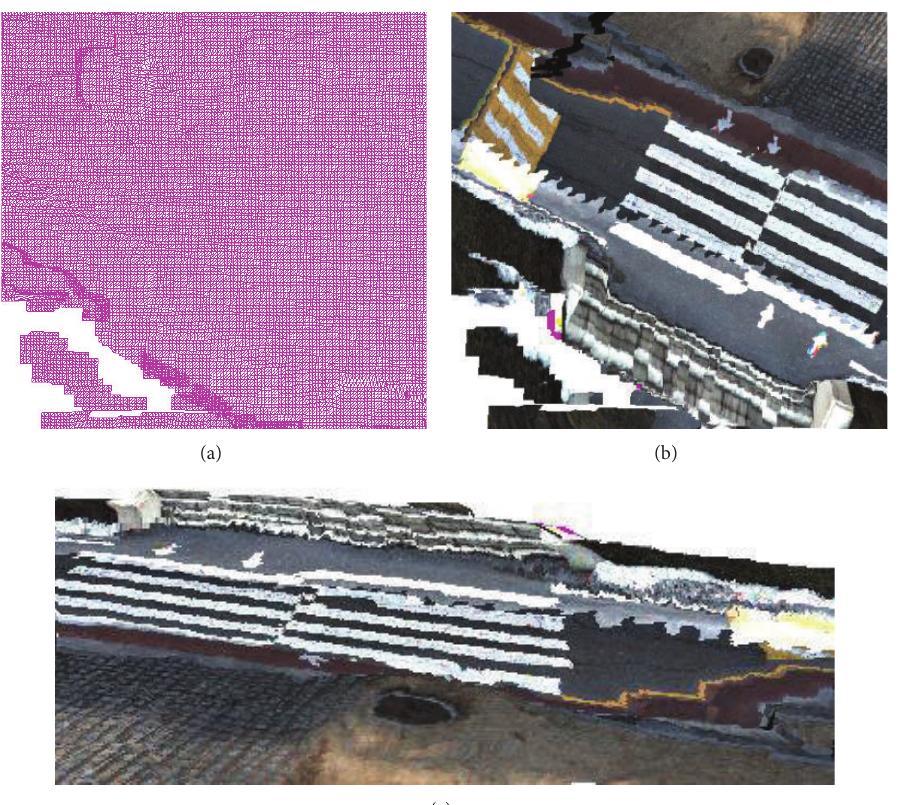
Figure 5: Texture mapping for MDB. (a) A node of the terrain mesh. (b) The node texture of (a). (c) Mapping the node texture onto the node